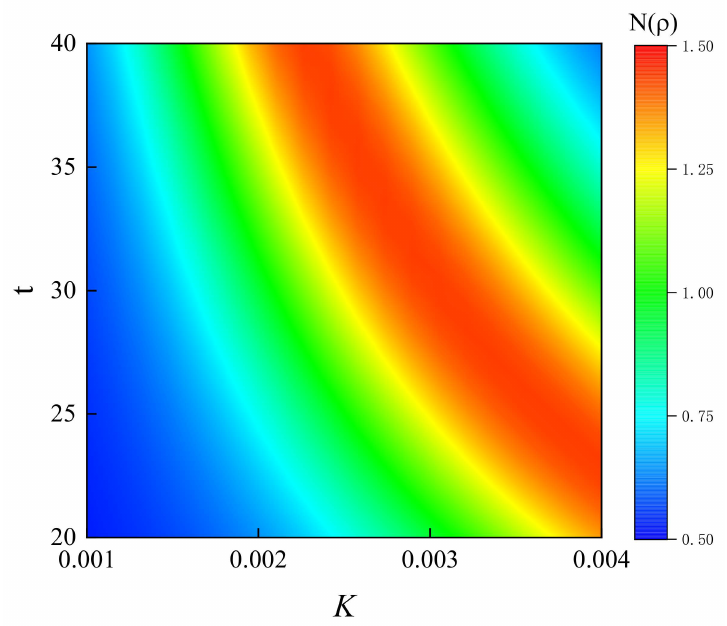
Figure 5. Field nonclassicality N ( ρ ) as a function of t . K is dimensionless in units of ω , g = 10 K , α a = 4 and α m =